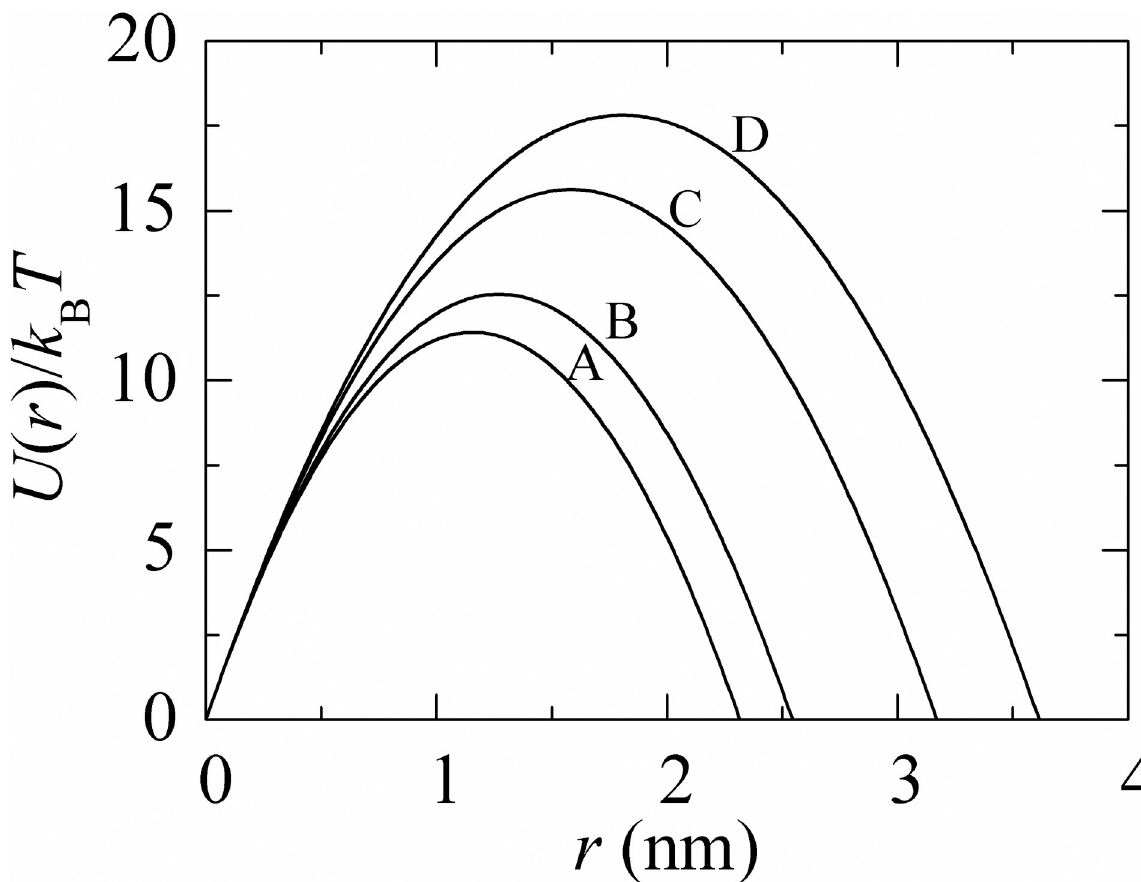
Fig 7. The prepore radius dependent free-energy profile of a prepore of DOPG/DOPC/chol (46/39/15)-GUVs under tension. (A) 9.0 mN/m (B) 8.0 mN/m (C) 6.0 mN/m and (D) 5.0 mN/m. U ( r , σ t ) was calculated according to Eq (6) using Γ = 12.9 pN.